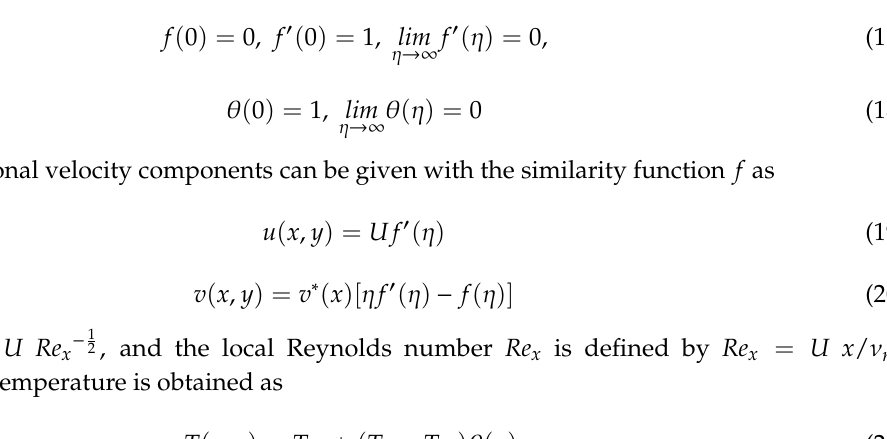
Figure 2. The dimensionless temperature profiles for 𝜙 = 0.02 for all three nanofluids with respect to similarity variable 𝜂 . The effect of the volume fraction 𝜙 is depicted in Figures 3 and 4. It was observed that increasing 𝜙 will slow down the fluid flow velocity and will increase the non-dimensional temperature.